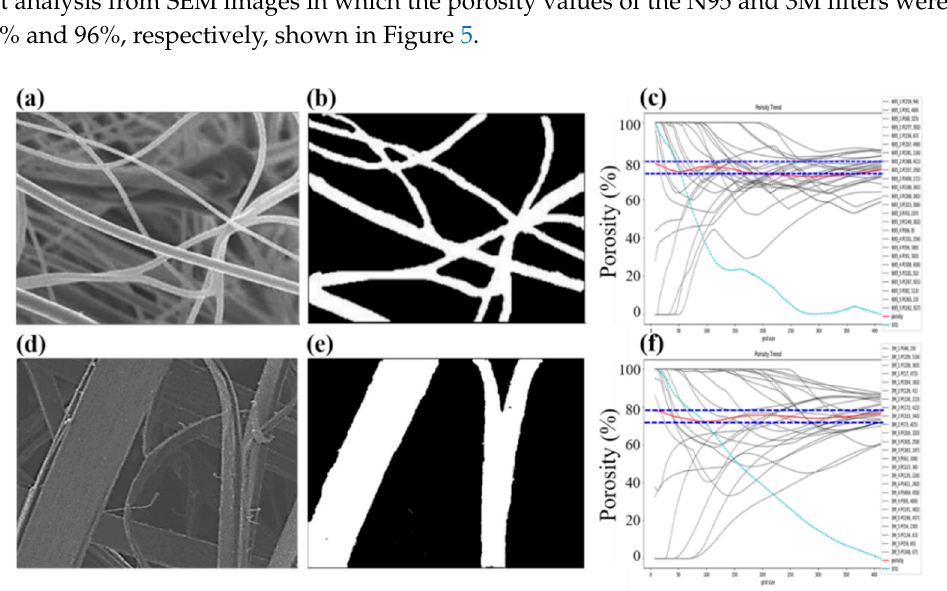
Figure 4. Theoretical analysis of collection efficiency and pressure drop of the N95 and 3M filters as a function of filter porosity.